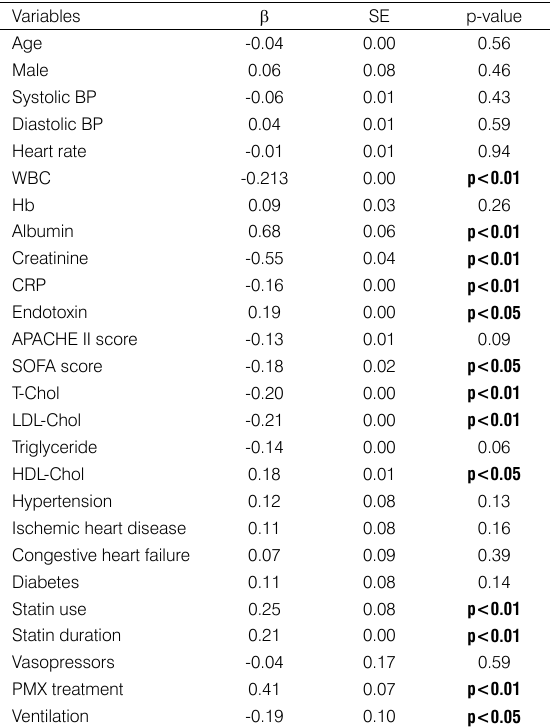
Table 3. Univariate analysis for correlates of 28-day